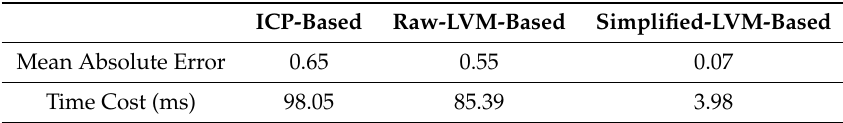
Figure 9. Demonstration of the results of LGM, LVM extraction, and vector-based matching. ( a ) the results of ground elimination. ( b ) the road boundaries segmented in one frame. ( c ) the fused local grid map of road boundaries (LGM). ( d ) road boundary candidate clusters (blue and yellow represent the hit road boundary and missed free space, respectively). ( e ) the raw local vectorization map (raw LVM). ( f ) the simplified local vectorization map (simplified LVM). ( g ) original unmatched road boundaries. ( h ) matched road boundaries using ICP. ( i ) matched road boundaries using raw-LVM-based matching. ( j ) matched road boundaries using simplified-LVM-based matching. Table 1. The comparison of the performance of